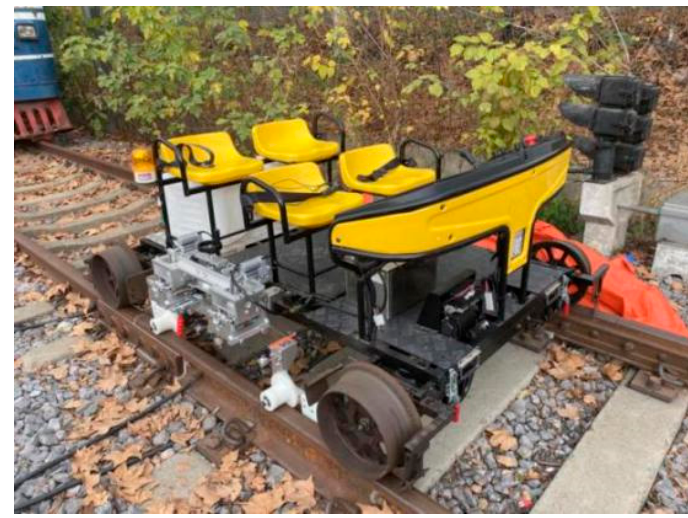
Figure 1. Physical picture of double-track rail fl aw detection vehicle.